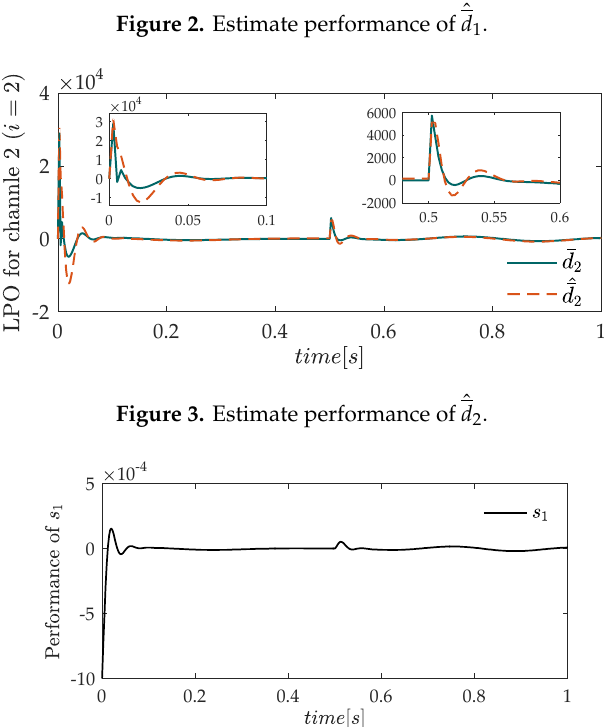
Figure 4. Trajectory of s 1 .